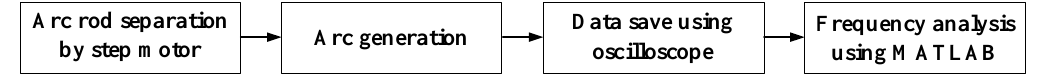
Figure 2. Flowchart of data accumulation and frequency analysis in this study.